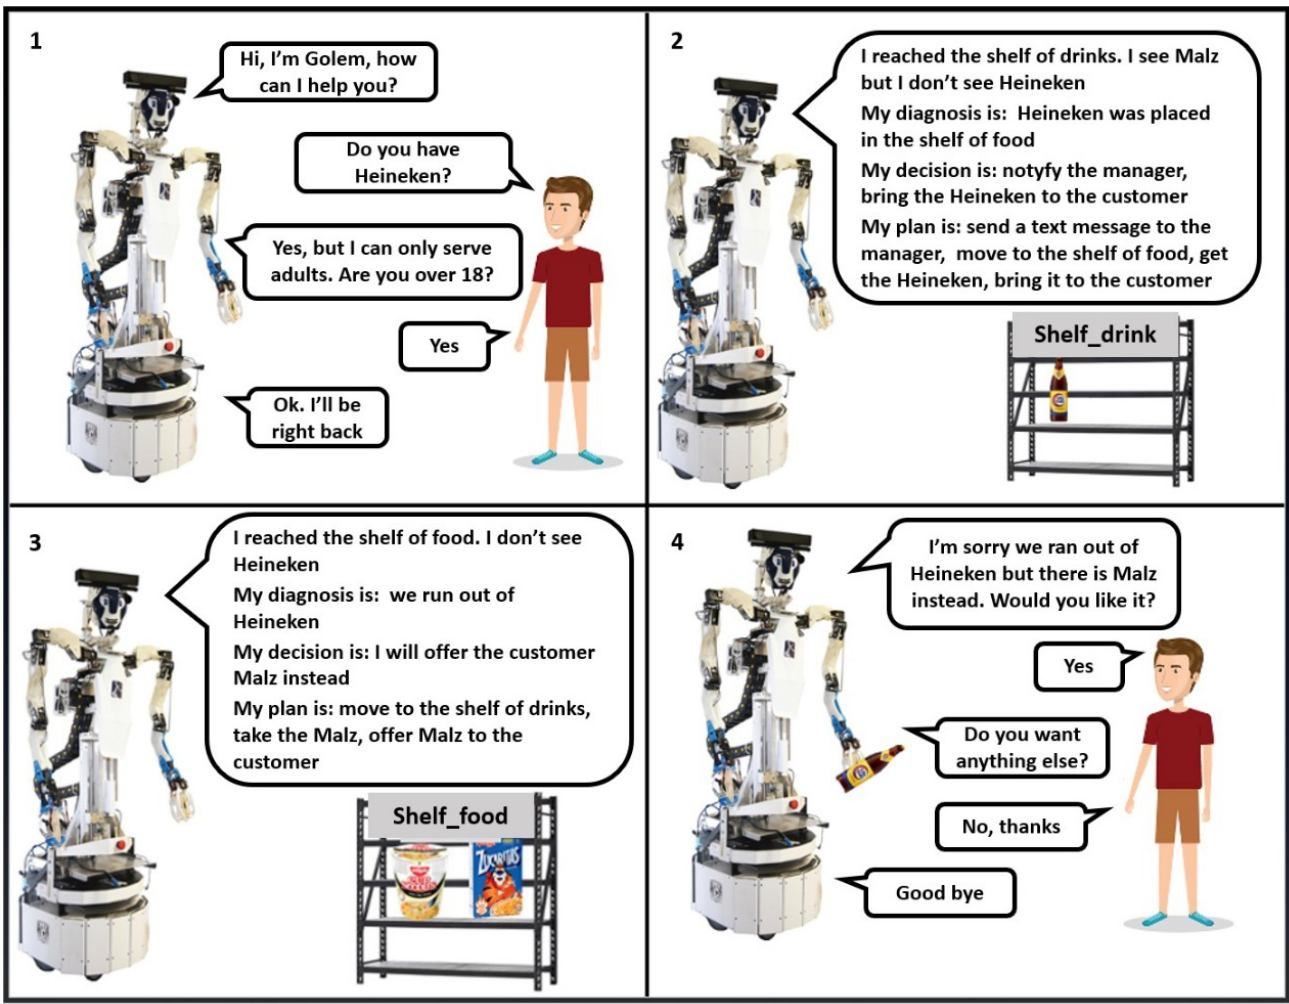
Figure 1. Common sense daily-life inference